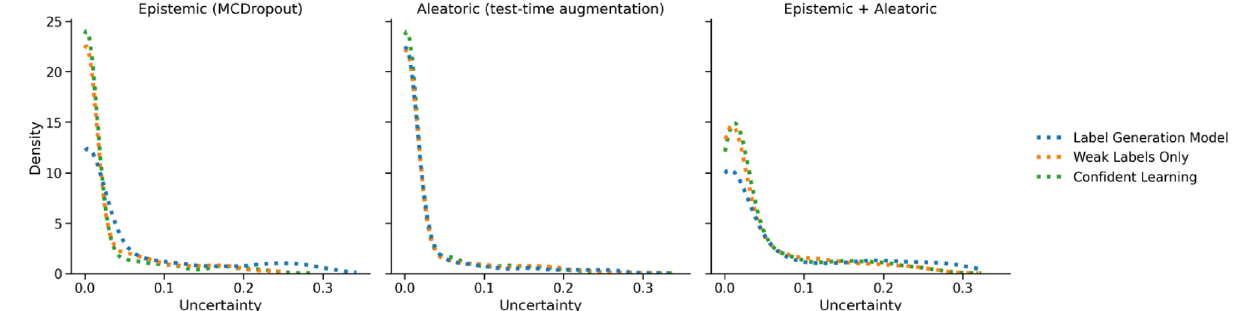
Figure 7. Density plots of uncertainty estimates using both MCDropout and test-time augmentation.